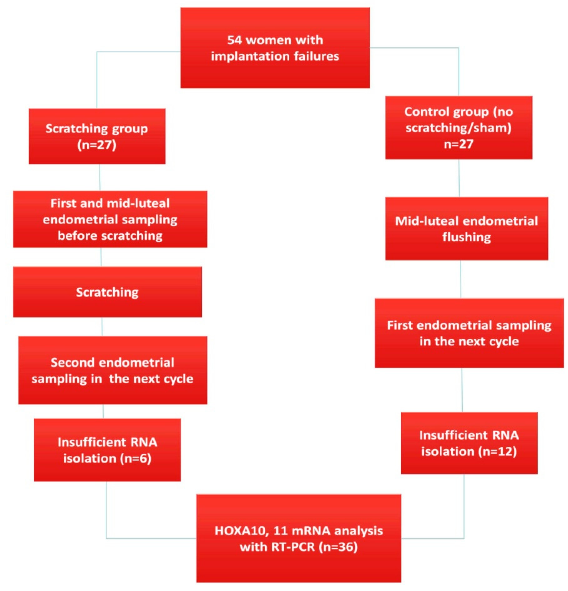
Figure 1. Patient selection flowchart representation of the participants in scratching and non-scratching groups.